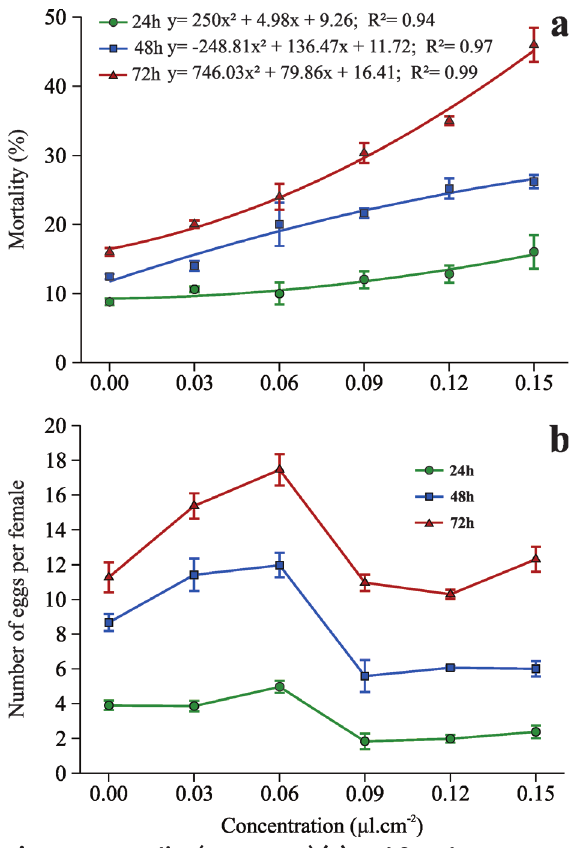
Figure 2. Mortality (mean ± SE) (a) and female fecundity (mean ± SE) (b) of Tetranychus urticae after contact exposure (24, 48 or 72 h) by Mentha piperita essential oil